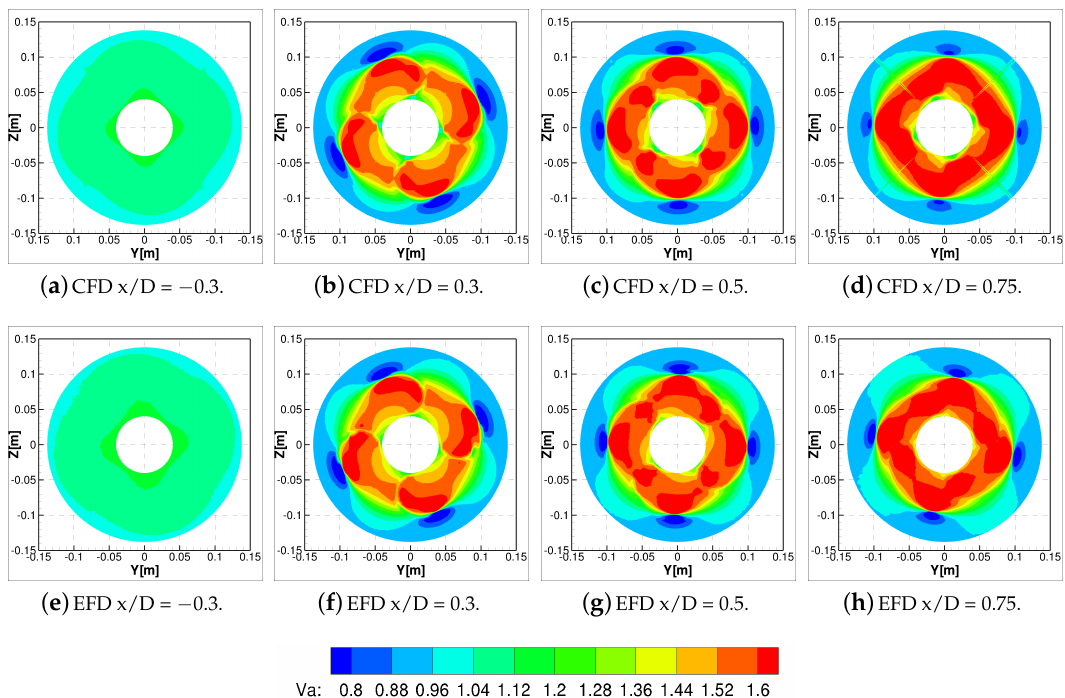
Figure 11. Axial non-dimensional velocity at different transversal sections for no-duct